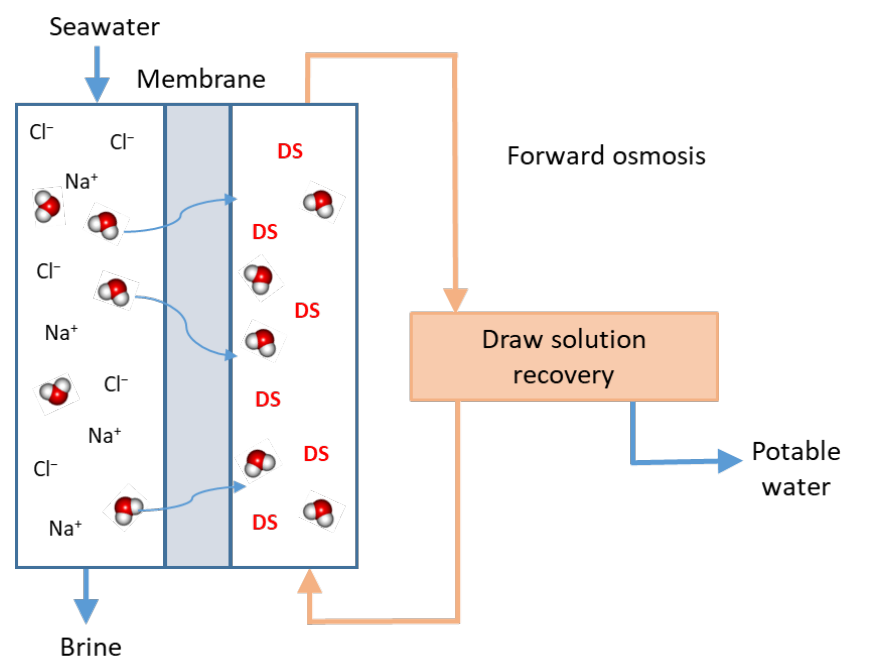
Figure 7. Schematic representation of a Forward Osmosis system.